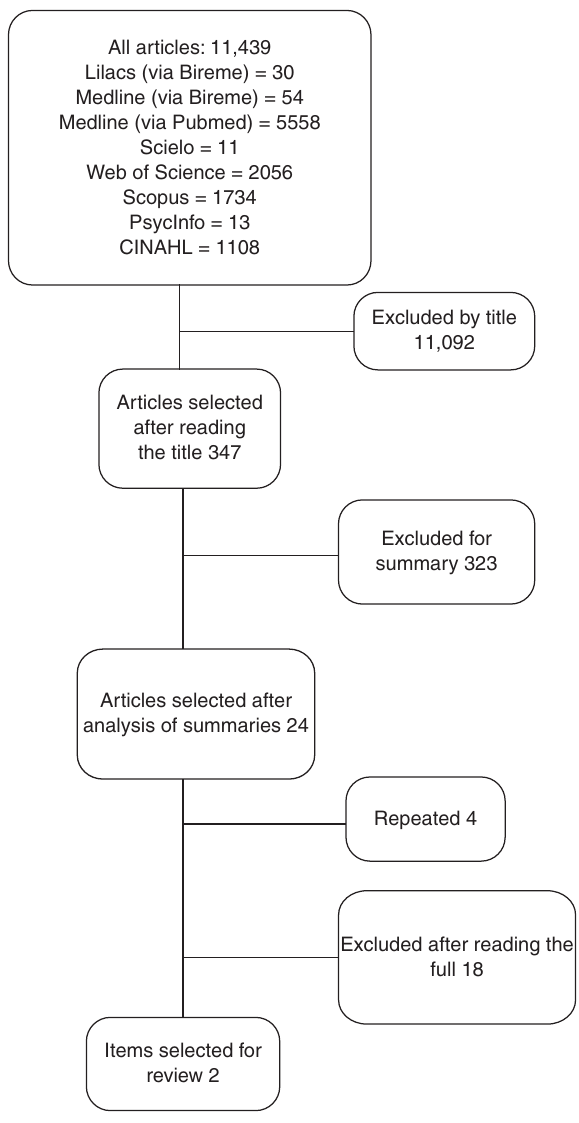
Figure 1 Flow chart: number of articles found.